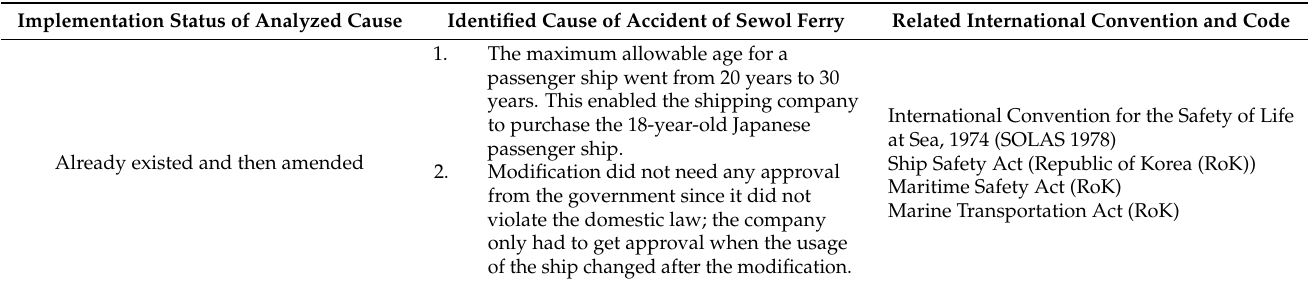
Table 3. Causes of the Sewol ferry accident and their application